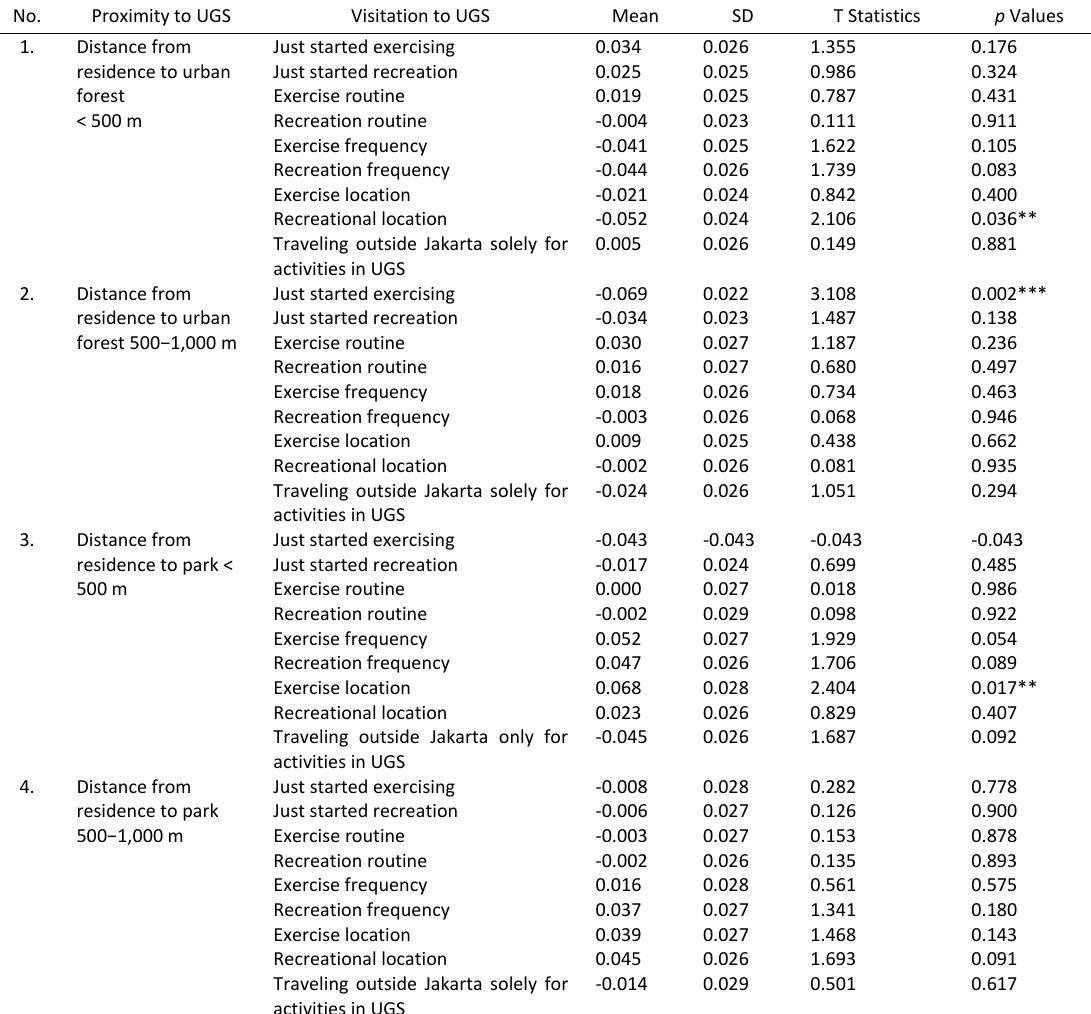
Table 6: The relationship between proximity to UGS and visitation to UGS using PLS‐SEM No.